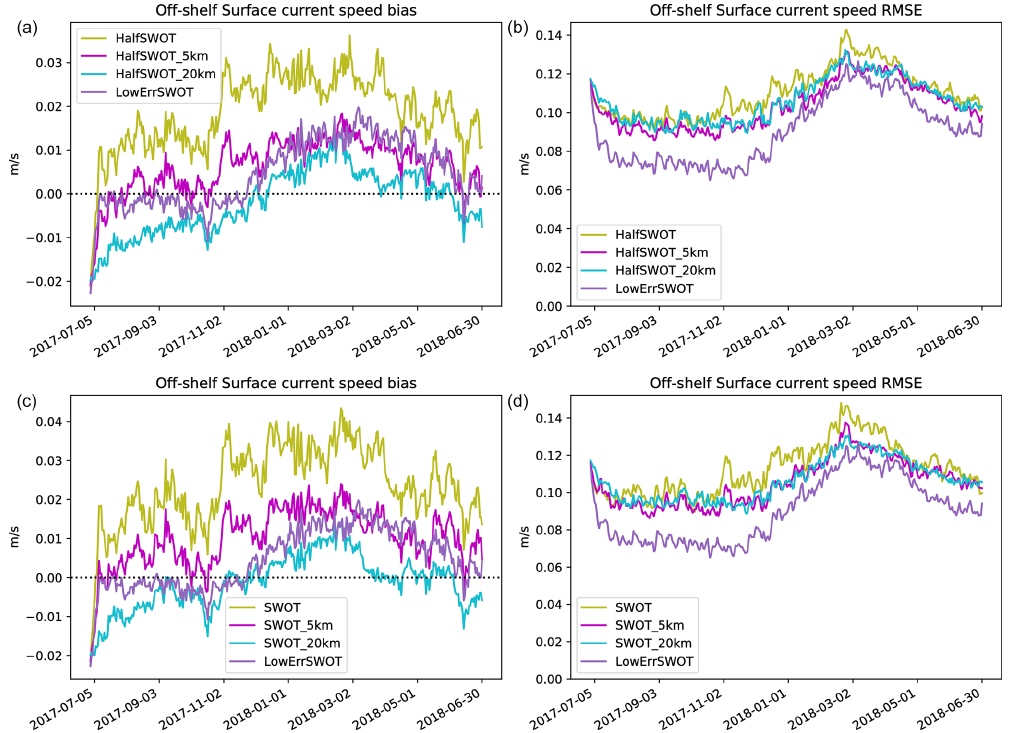
Figure 17. Off-shelf surface current speed bias (a,c) and RMSE (c,d) for the HalfSWOT (a,b) and SWOT (c,d) experiments showing the impact of observation averaging. The LowErrSWOT experiment is also shown in both